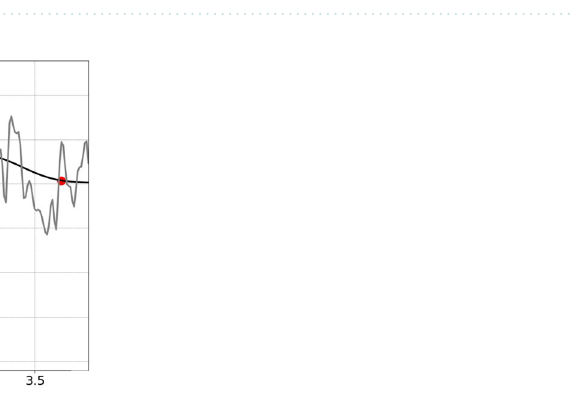
Figure 11. RGB and NIR forehead pixel temporal signals. The peaks and troughs are marked with black dots for the red, green, blue and NIR channels ( a , b , c , d ), respectively.